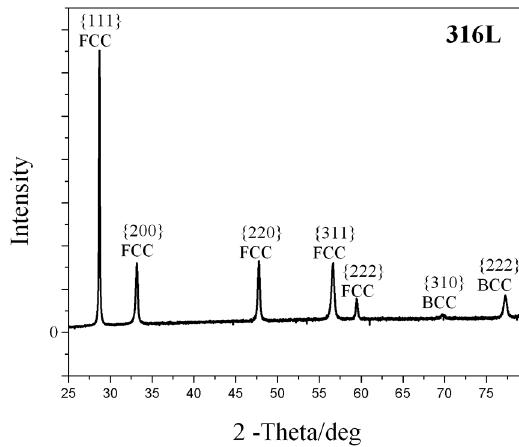
Figure 5. XRD pattern for the 316L steel in the as received condition (synchrotron light radiation source, λ = 0.10332 nm).